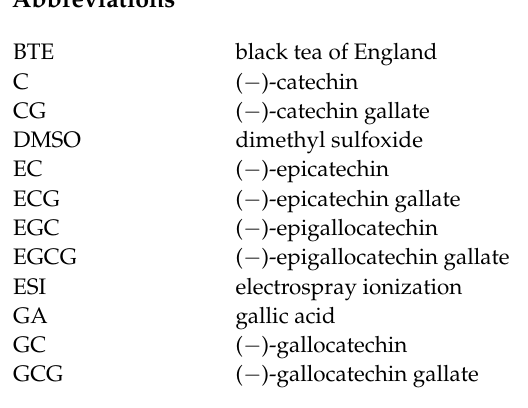
Figure S4: Post-processing scheme for obtaining valid UV data, Table S1: Concentrations (mg/g) of phenolics and caffeine in commercial teas determined by an HPLC system equipped with a UV detector (manually processed), Table S2: Operation cost comparison of phenolic separation using HPLC-UV-MS and